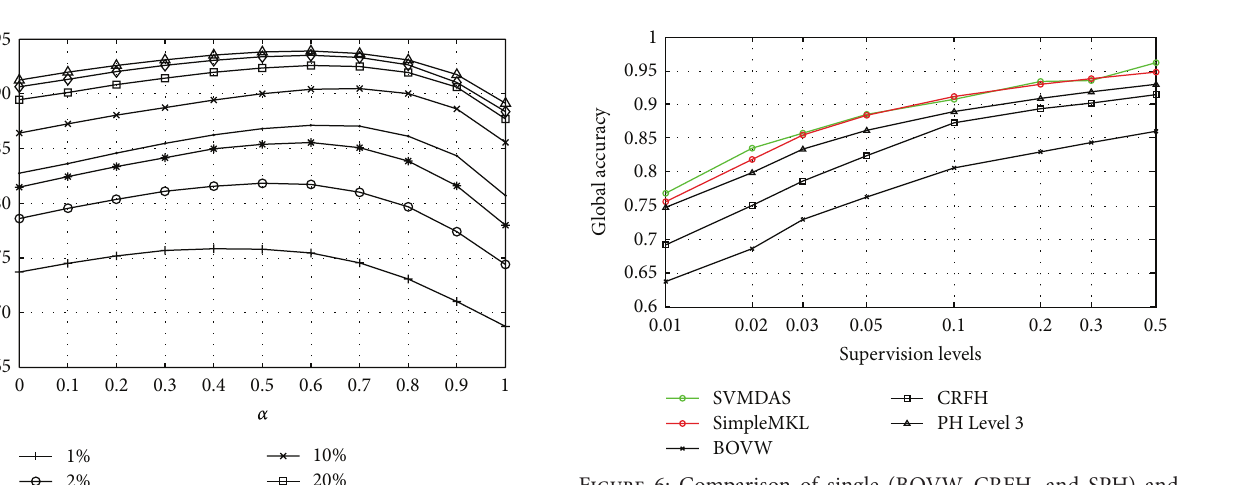
Figure 6: Comparison of single (BOVW, CRFH, and SPH) and multiple feature (SVMDAS, SimpleMKL) approaches for different supervision levels. Plot of the accuracy as a function of the supervision level (IDOL2 dataset, random